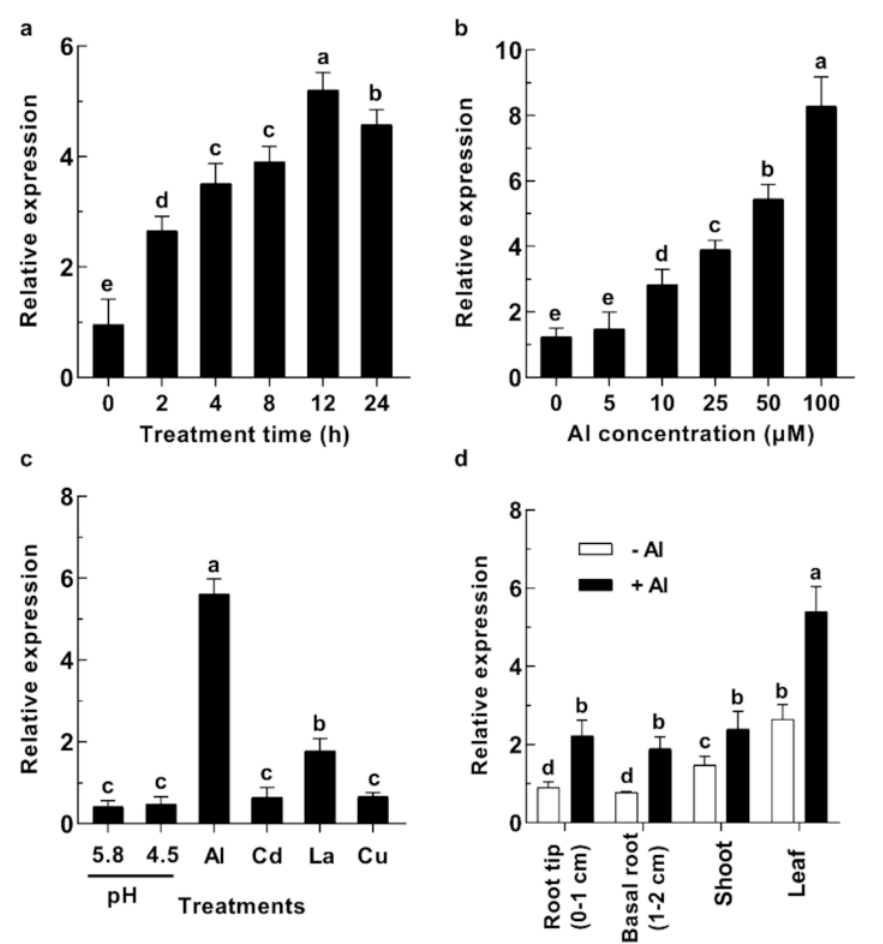
Figure 3. The detection of the GsABCI1 expression pattern. ( a ) Time-dependent expression pattern of GsABCI1 . Plants were treated with a solution containing 50 µ M AlCl 3 for 0, 2, 4, 8, 12, and 24 h. Root tips (0–1 cm) were collected for qPCR after different time treatments. ( b ) Dose-dependent expression pattern of GsABCI1 . Plants were exposed to a solution containing 0, 5, 10, 25, 50, or 100 µ M AlCl 3 for 8 h. Root tips (0–1 cm) were collected for qPCR after 8 h in different Al treatments. ( c ) The GsABCI1 expression of response to metals and different pH values. Seedling plants were grown under different pH (pH 4.5, or 5.8) conditions or in solutions (pH 4.5) containing 50 µ M AlCl 3 , 23 µ M CdCl 3 , 10 µ M LaCl 3 , or 0.5 µ M CuCl 2 for 8 h. Root tips (0–1 cm) were collected for qPCR after 8 h in different treatments. ( d ) Tissue-specific expression pattern of GsABCI1 . Seedling plants were cultivated in a solution with 0 or 50 µ M AlCl 3 for 12 h. Root tips (0–1 cm), Basal roots (1–2 cm), shoots, and leaves were collected for qPCR after treatment. The expression levels of all candidate genes were determined by using the 2 − ∆∆ ct method. The data are the means ± SDs ( n = 3). The different letters indicate significant differences at p < 0.05 as determined by Student’s t